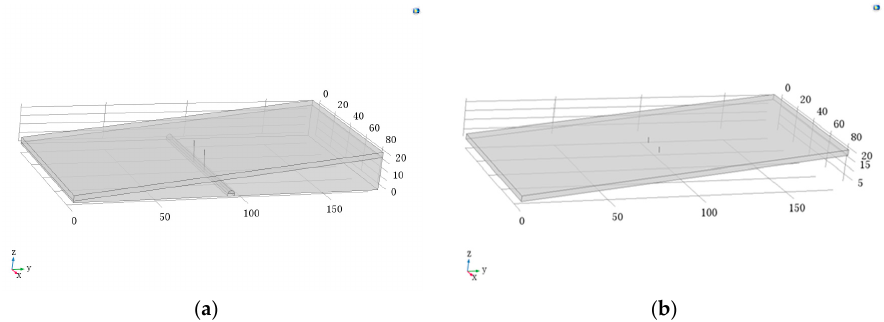
Figure 2. ( a ) Geometrical models of the coal seam, rock strata, and borehole; ( b ) geometrical models of the coal seam and the borehole.